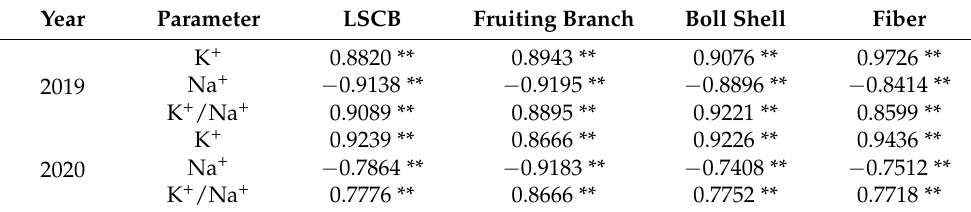
** indicates significant differences at the 0.01 probability